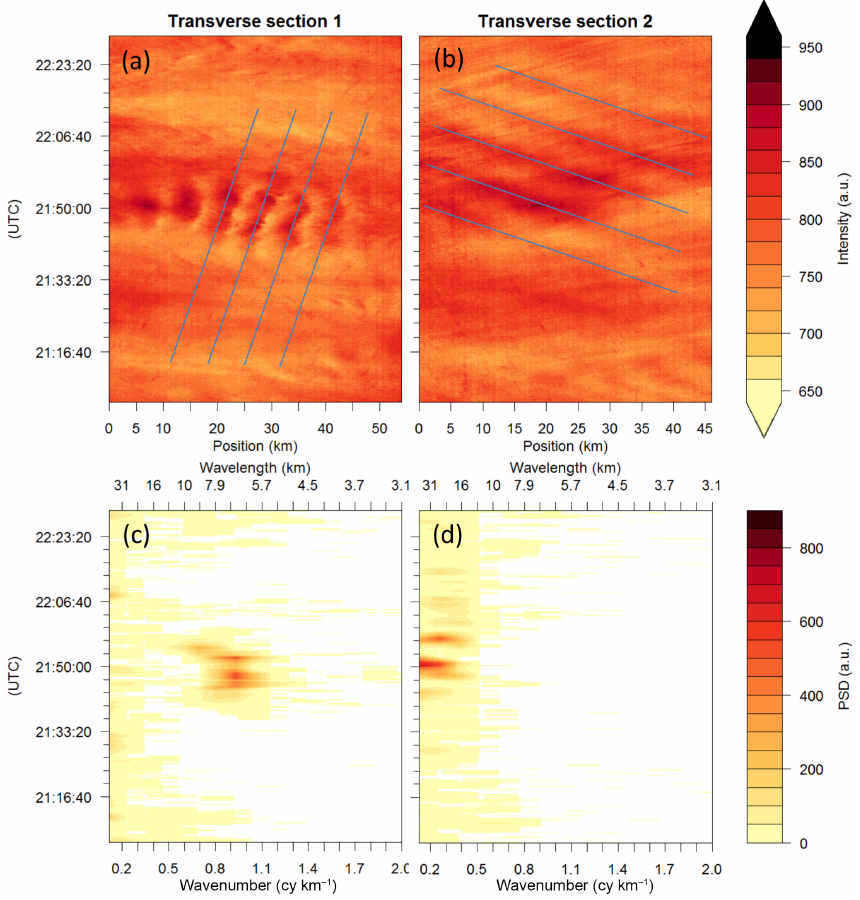
Figure 9. (a, b) show the temporal evolution of the transverse sections of wave (I) and wave (II). The lines indicate the position of the wavefronts. The abscissa corresponds to the position within the transverse sections shown in Fig. 8 (axis origin corresponds to the upper part of the transverse sections). Panels (c, d) show the Fourier transforms of each line of (a, b) respectively. The white areas are not significant on a